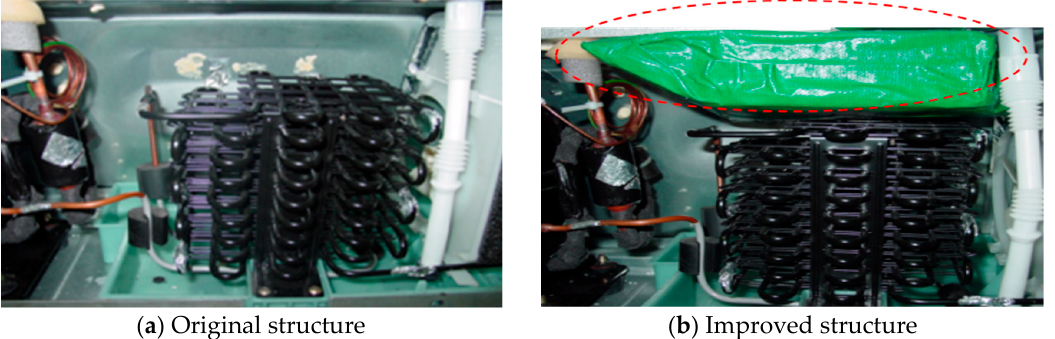
Figure 8. Original and modified model of the machine room.